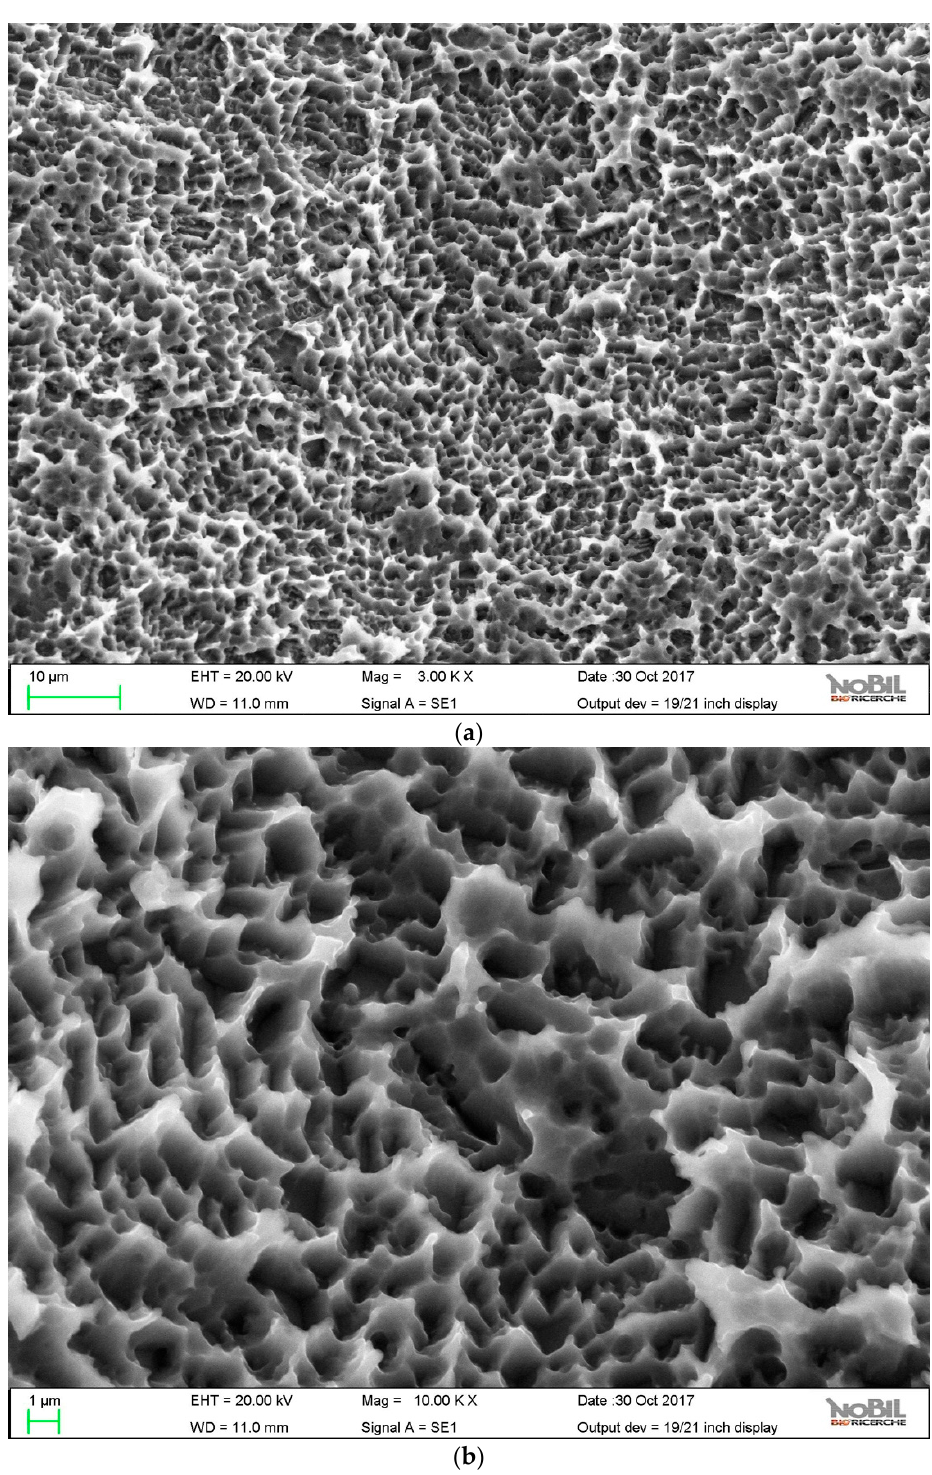
Figure 2. SEM images of the control implant surface, ( a ) 3000 × ; ( b ) 10,000 ×